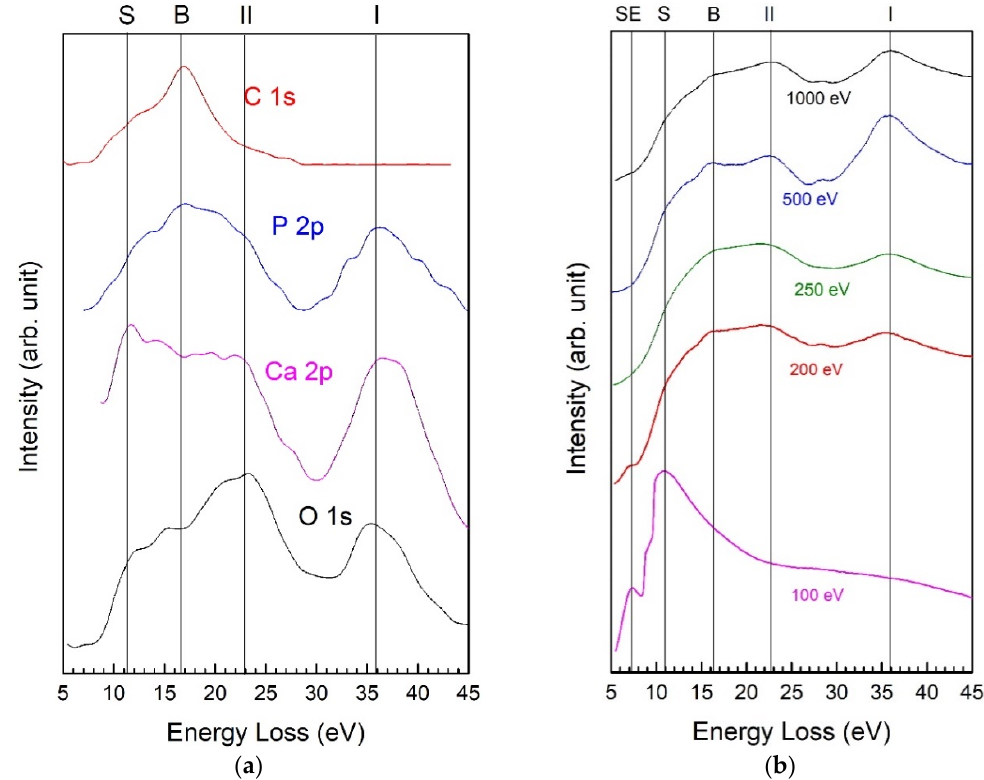
Figure 5. Electron energy losses in XPS spectra ( a ) and REELS spectra recorded in a primary energy range of 100–1000 eV ( b ) for the HA-FCC reference sample.